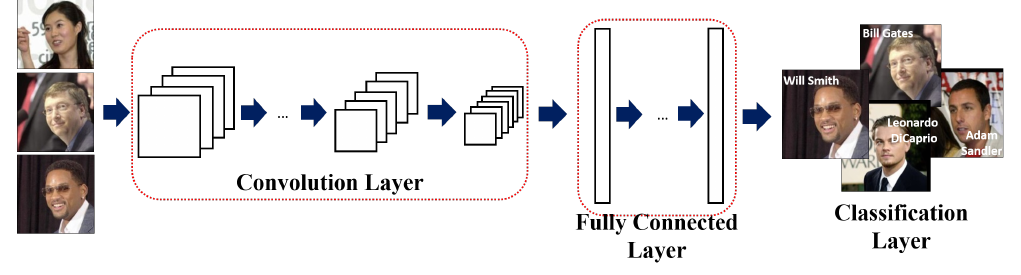
Figure 1. An overview of a generic CNN